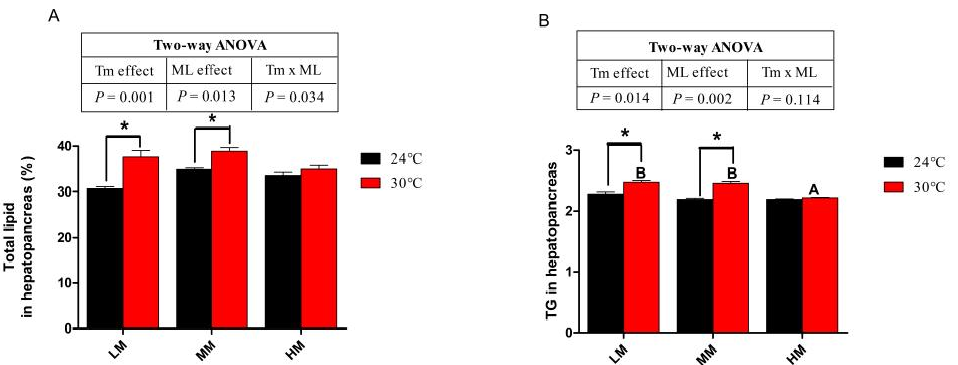
Figure 1. The total lipid ( A ) and triglyceride contents ( B ) in the hepatopancreas of juvenile E. sinensis fed the experimental diets at normal (24 °C)/high water temperature (30 °C). * means that there is a significant difference between different temperatures at the same dietary methionine level ( p < 0.05). The A and B indicate significant differences among crabs fed diets with different dietary methionine levels at high water temperature ( p < 0.05).